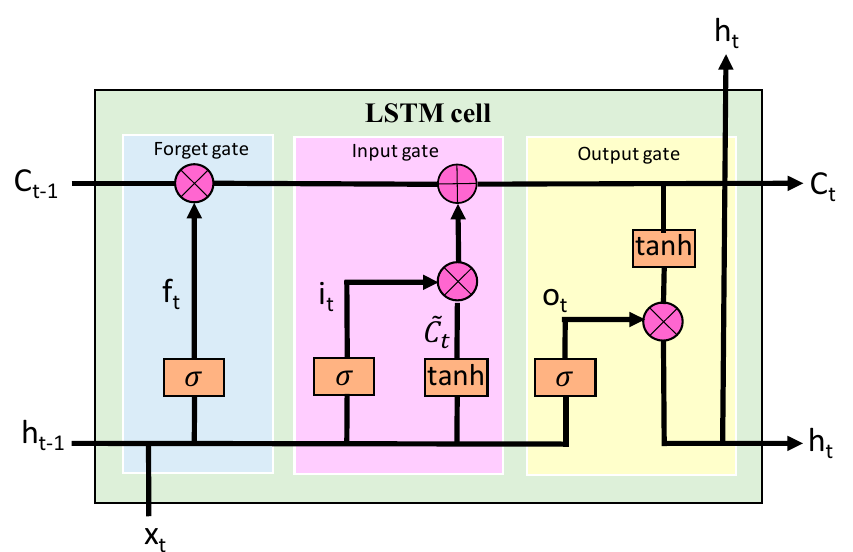
Figure 4. Architecture of the long short-term memory (LSTM) cell. The cell state ( C t ) indicates the status of the internal storage and data in the cell. The cell state changes according to the status of the LSTM cell. As displayed in Figure 3, few linear operations appear on the horizontal line running through the top of the